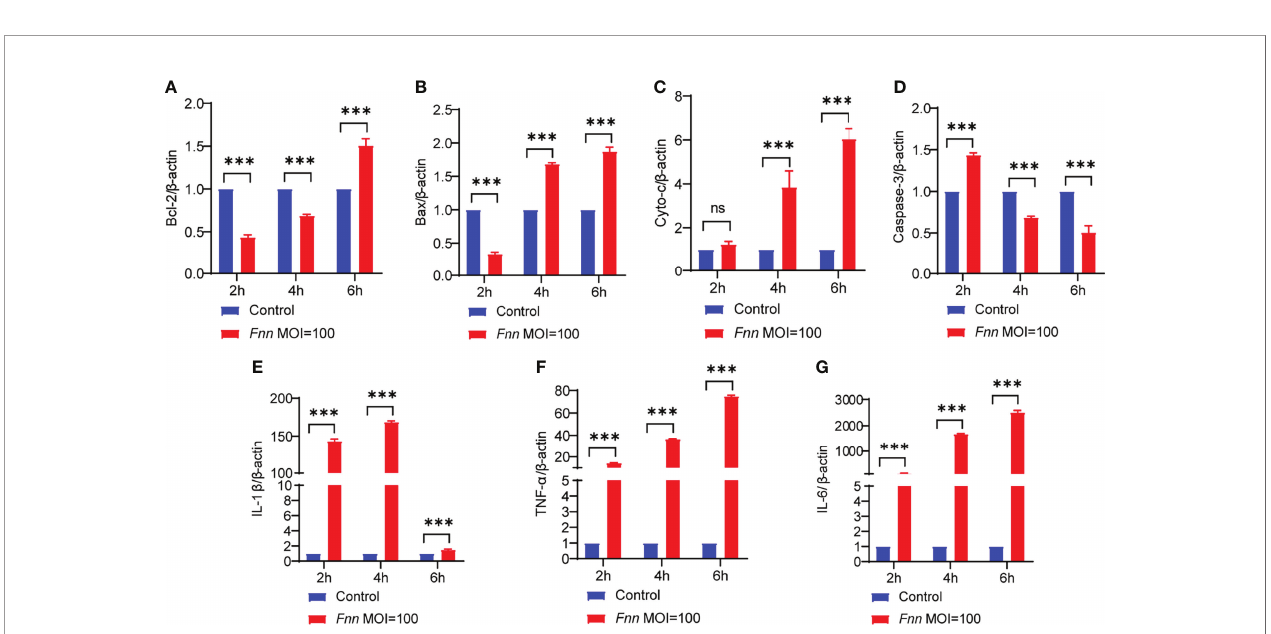
FIGURE 7 | The effect of F. necrophorum on apoptosis and in fl ammatory factors of sheep neutrophils cells was detected by RT-qPCR. Bcl-2 (A) , Bax (B) , cyto-c (C) , caspase-3 (D) , IL-1 b (E) , TNF- a (F) and IL-6 (G) gene expression with F. necrophorum stimulation (MOIs of 0 and 100) from 0 to 6 h ( n = 3). *** P <0.001, ns, not signi fi